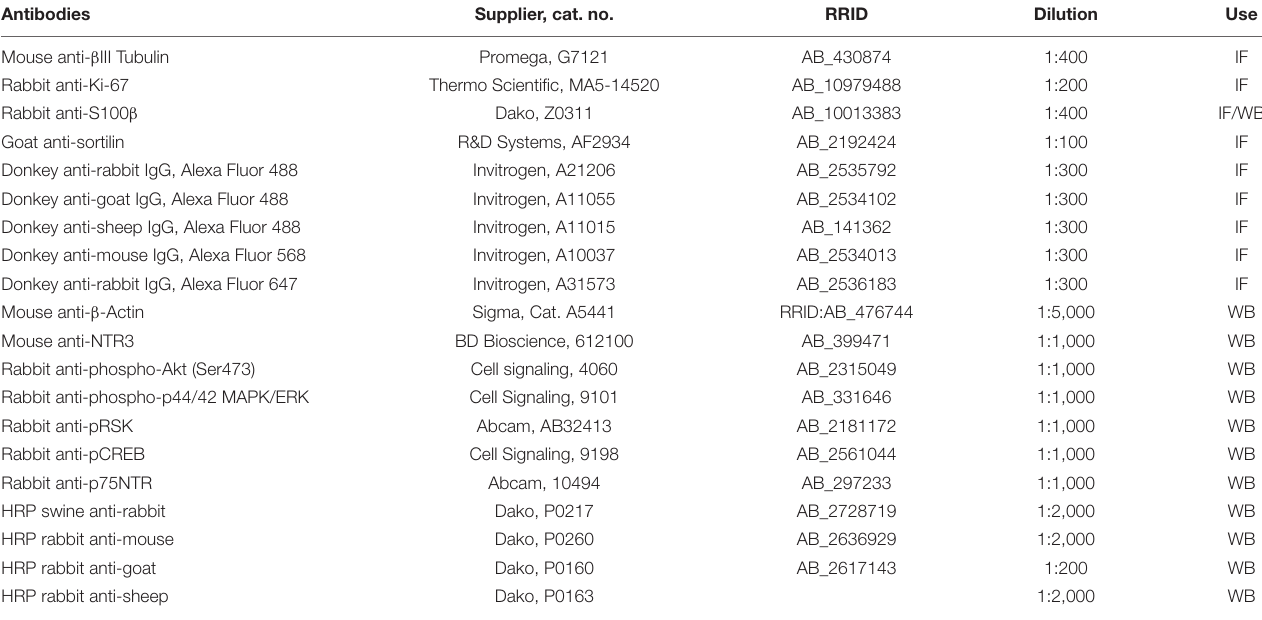
TABLE 1 | List of antibodies used.